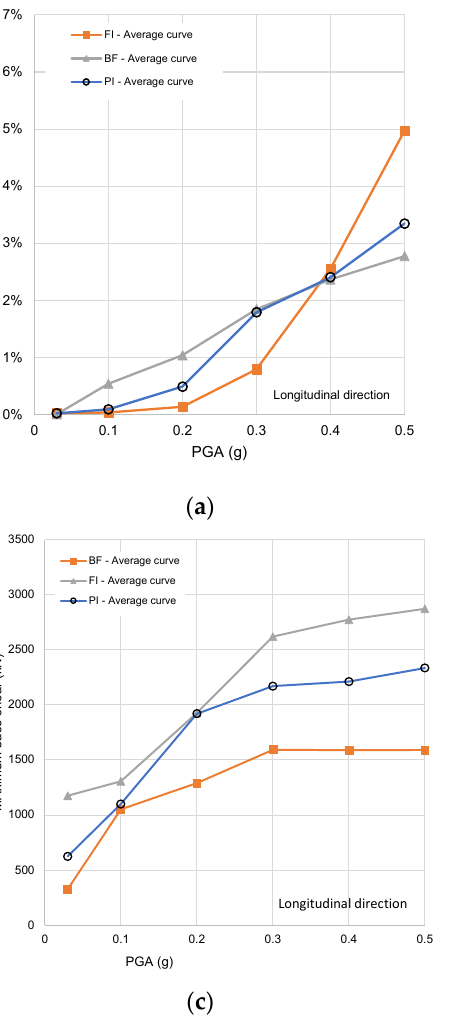
Figure 9. Nonlinear dynamic analyses: maximum inter-story drift ratio: ( a ) longitudinal and ( b ) transverse direction. Maximum base shear: ( c ) longitudinal and ( d ) transverse direction.